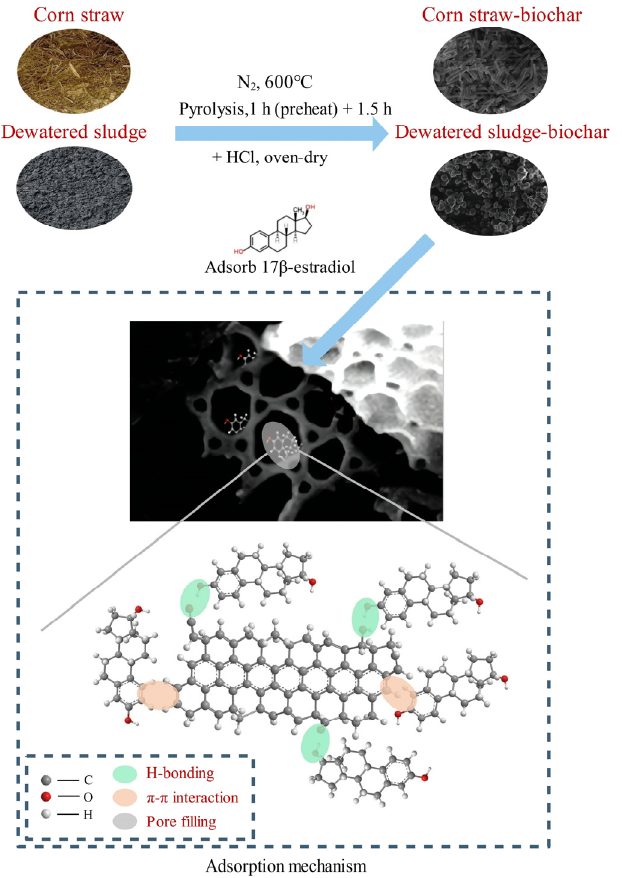
Figure 6. The proposed mechanisms for E2 adsorption on biochars.